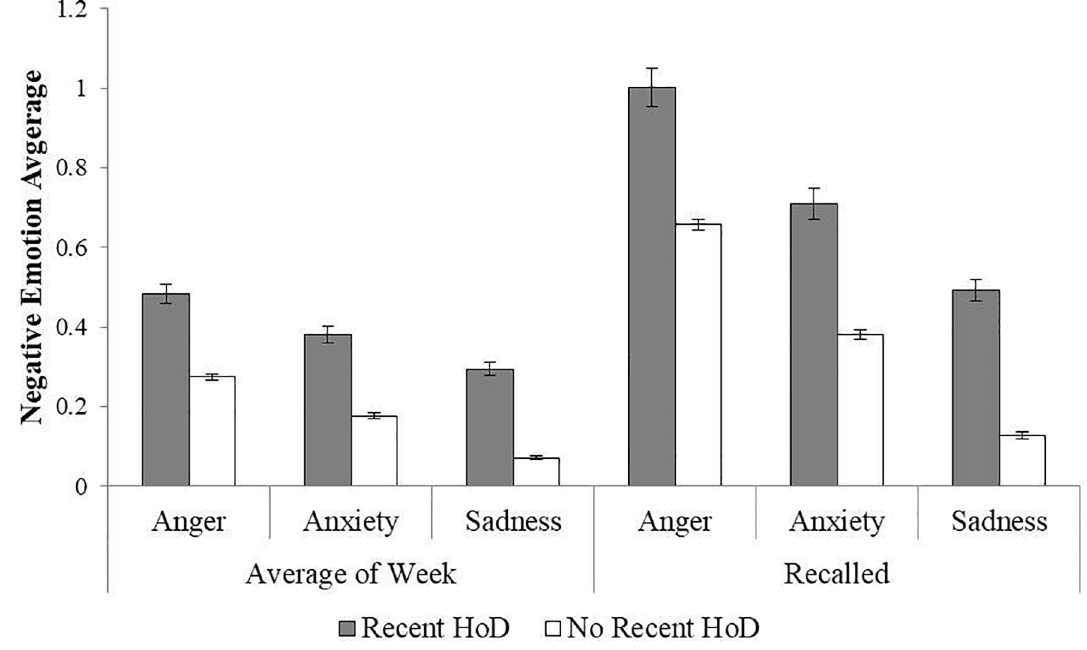
Fig 2. Negative clusters by recent history of depression. Note . Error bars represent standard error values. HoD = History of Depression. The model is adjusted for gender and evaluated at the following values: Age = 56.67, Education = 7.39.